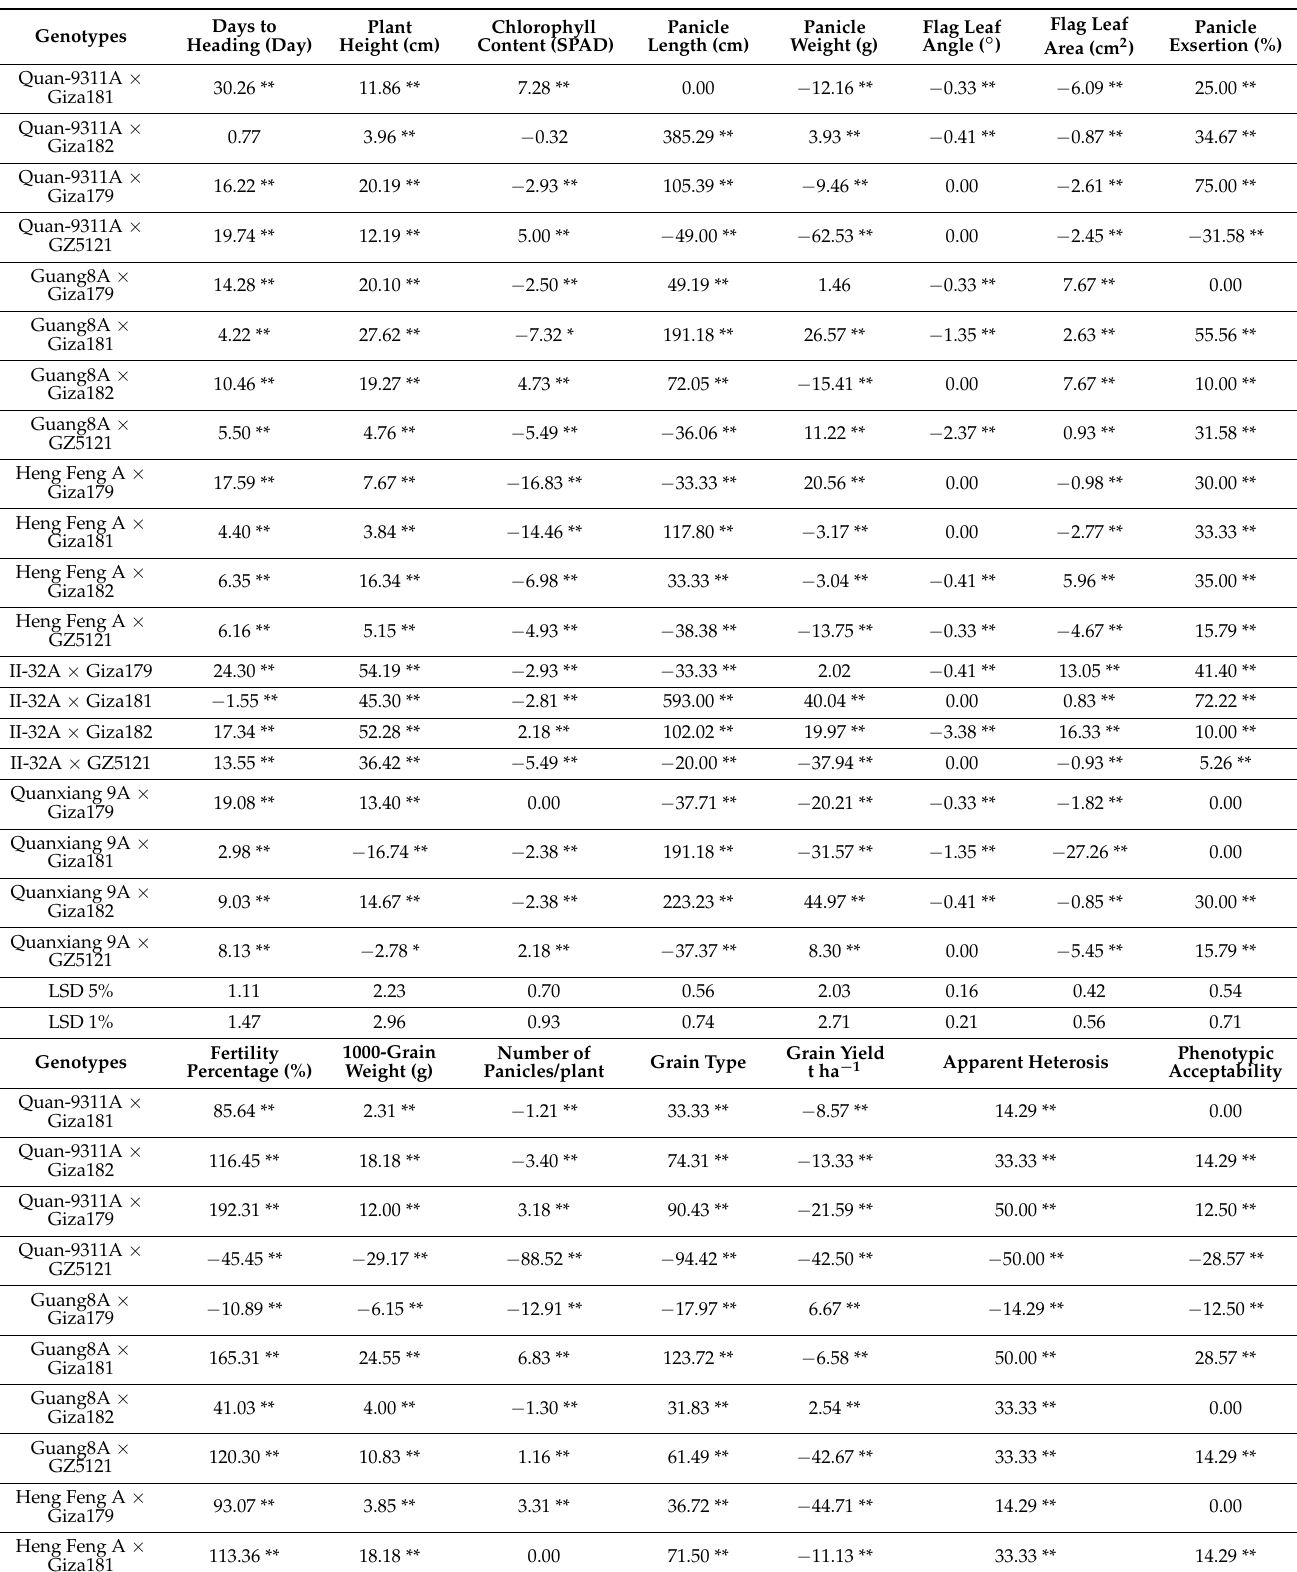
Table 5. Heterosis over better parent for studied